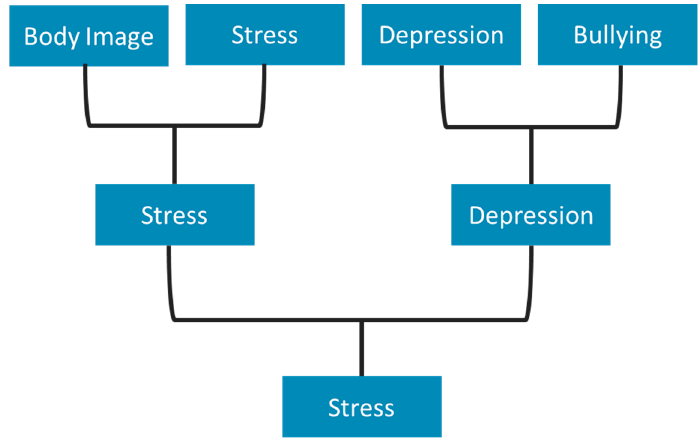
Figure 1. Example of a voting bracket, as proposed for session three.